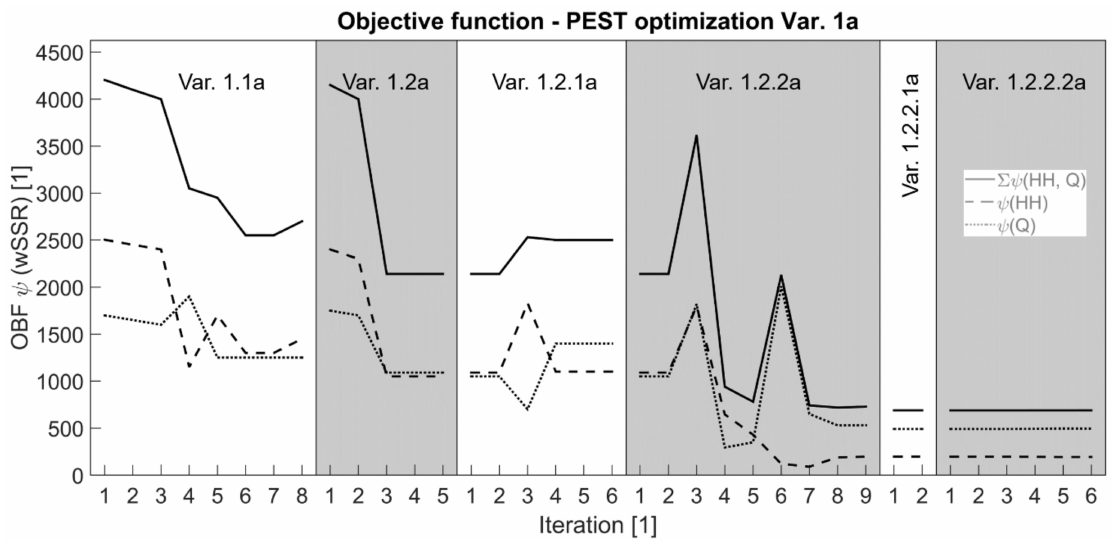
Figure 6. Objective functions (OBF) of PEST optimization for Var. 1a with different adjustments in the initial parameters, the termination criteria and parameter